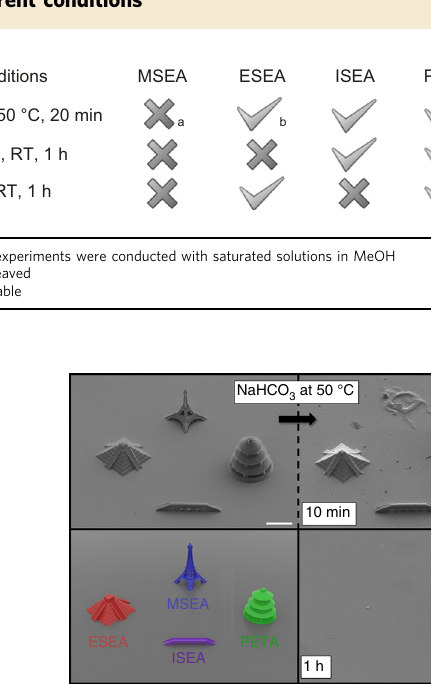
Table 1 Orthogonality studies of direct laser written structures composed of MSEA, ESEA, ISEA or PETA under three different conditions